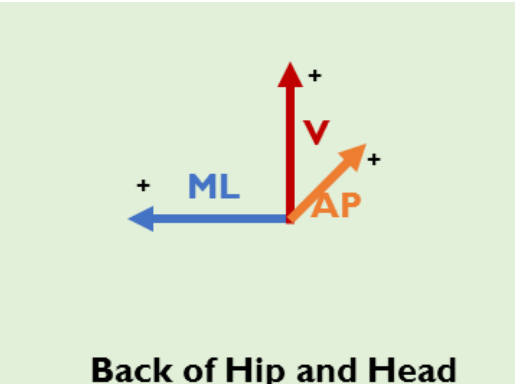
Figure 5. As for accelerometers located on the hip and head, the X , Y , and Z axes represent V, ML, and AP directions, respectively.